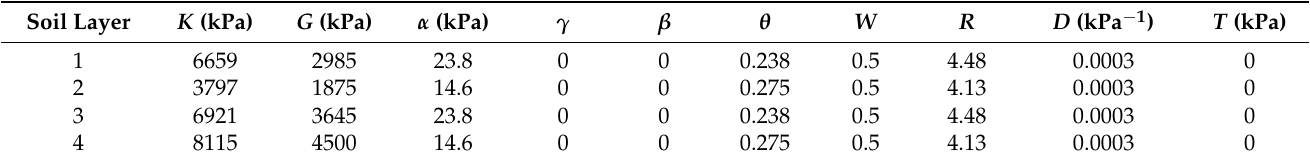
Figure 4. ( a ) Finite element model and boundary conditions; ( b ) Soil profile of the A-A section. Table 2. Material parameters for pile jacking analysis.